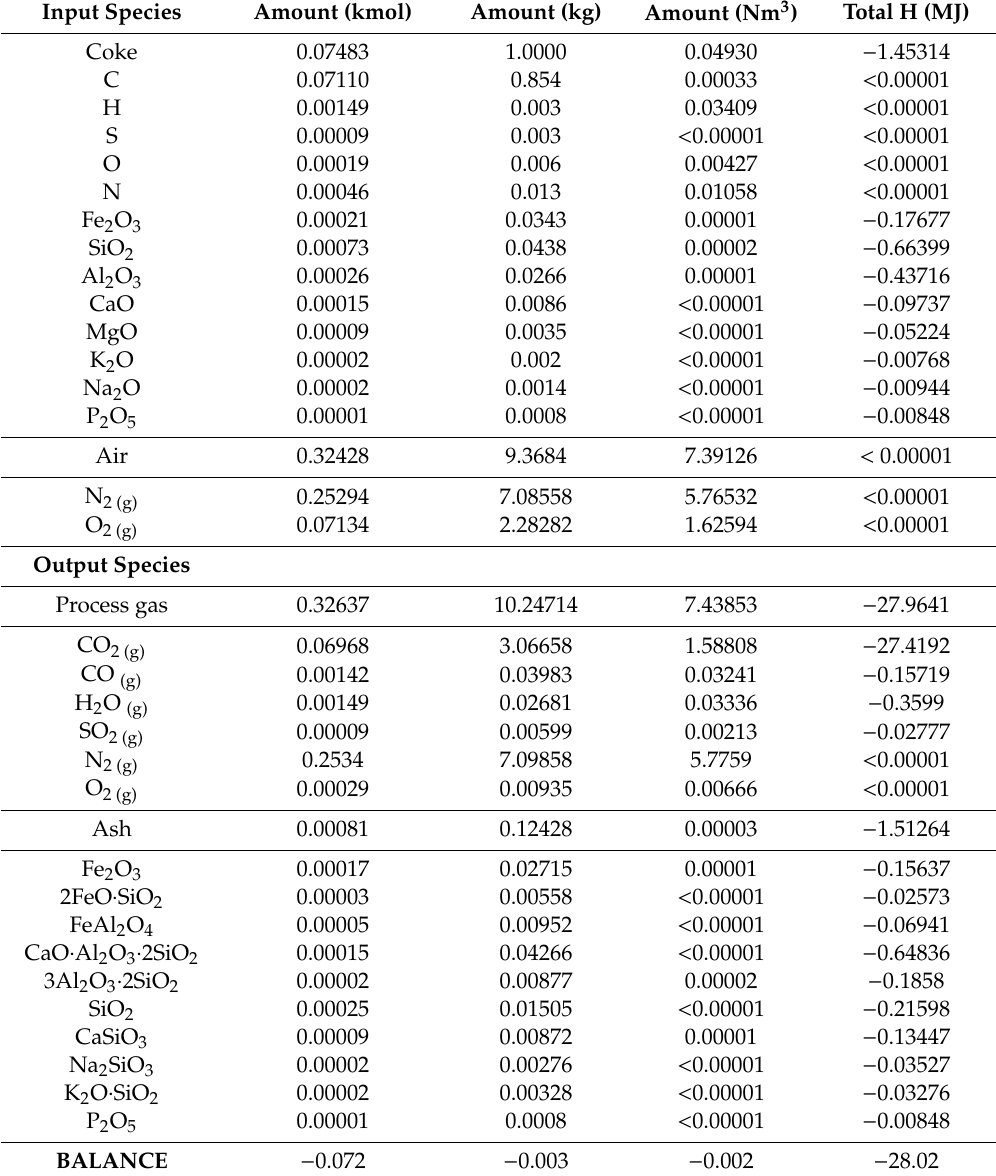
Table 5. Mass and thermal balance of coke combustion process (calculation for 1 kg of